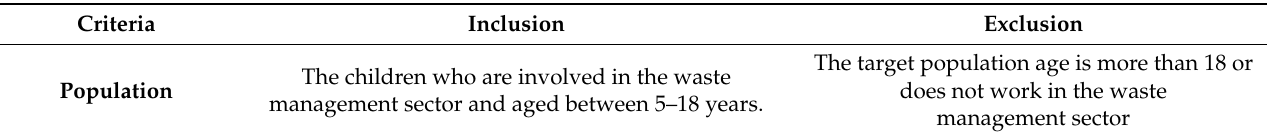
Table 1. Description of Inclusion and Exclusion Criteria (Modified PICOTS method).